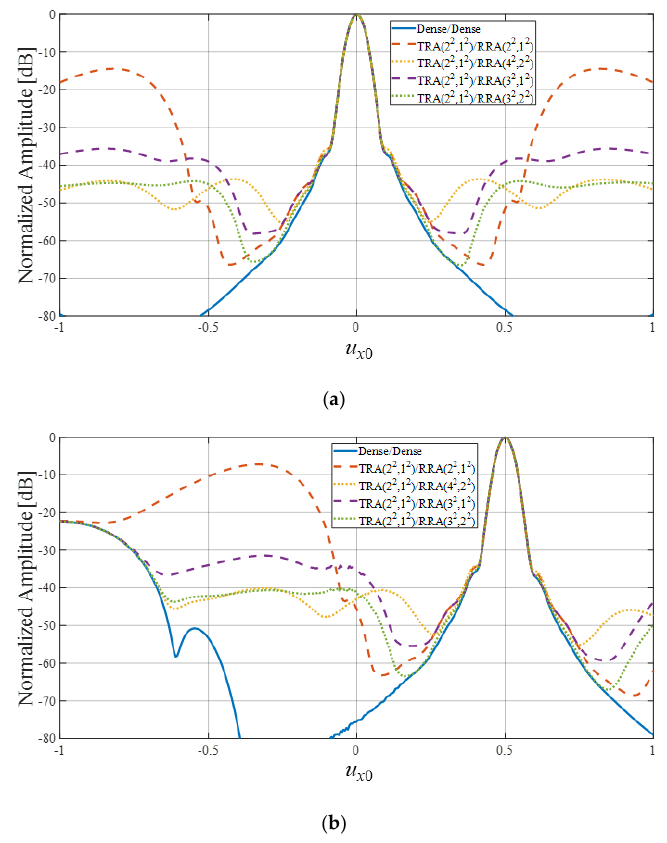
Figure 10. One-dimensional (1D) profiles ( u y 0 = 0) of ( a ) non-steered and ( b ) steered PW PSFs of the rectangular array pairs. The steered focal point was set to ( u x f , u y f ) = (0.5,0) (i.e., θ f = π/6, and φ f = 0). For quantitative comparison, the main lobe BWs, MSR, and PGL of all the SRA pairs in Figure 10 (except for TRA(2 2 ,1 2 )/RRA(4 2 ,1 2 )) were measured and are listed in Table 1 in the ascending order